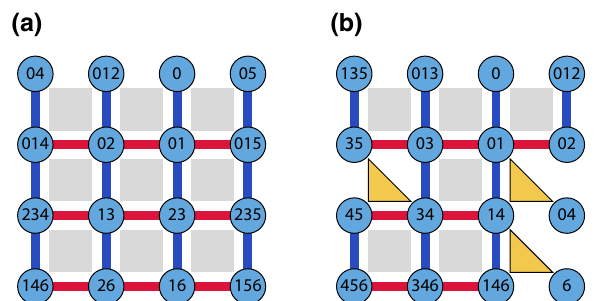
FIG. 3. Constraint-layout examples with partitioning into three- and four-body constraints. (a) The special case with only four-body constraints for which the driver lines may be cho- sen to be strictly horizontal or vertical and can be parallelized trivially. (b) A general example with both three- and four-body constraints. The implementation of all three-body constraints explicitly still allows for parallel execution of all horizontal (ver- tical) lines. The shown driver terms preserve all four-body con- straints (gray), while three-body constraints have to be explicitly enforced in ˆ H C (yellow). The driver line in the first row is omit- ted, as it can be obtained via symmetric difference of the others. Qubits not involved in any of the shown driver lines are part of a single-qubit driver (not